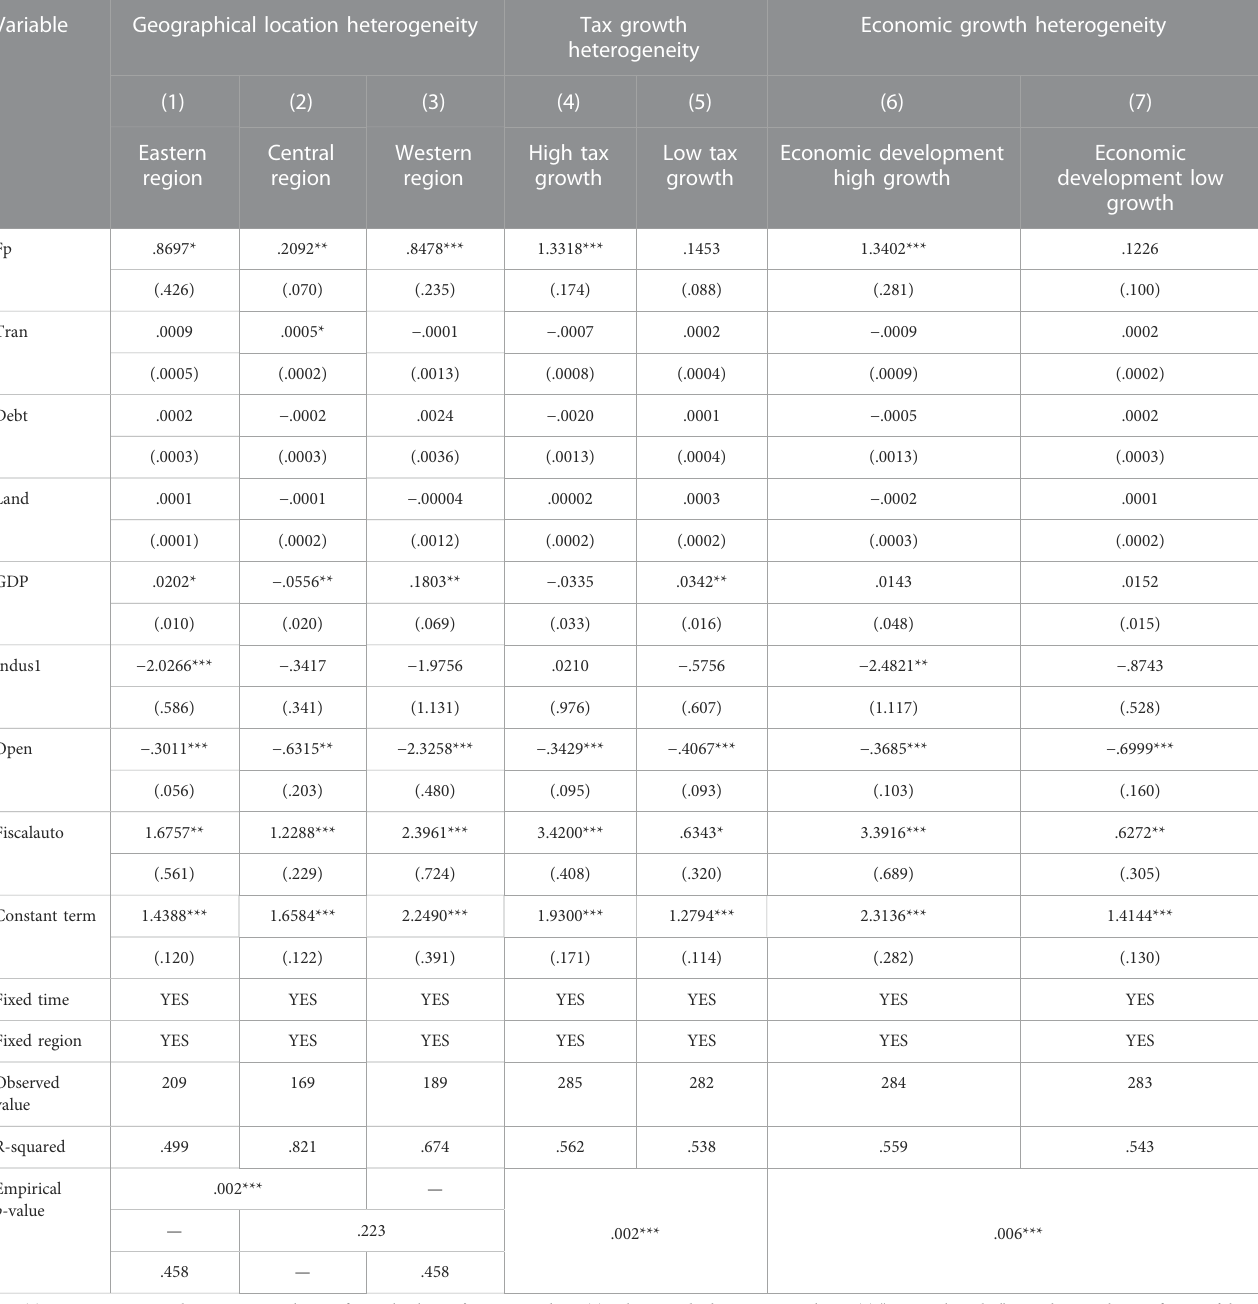
TABLE 4 Results of heterogeneity analysis of fi scal pressure on tax efforts.